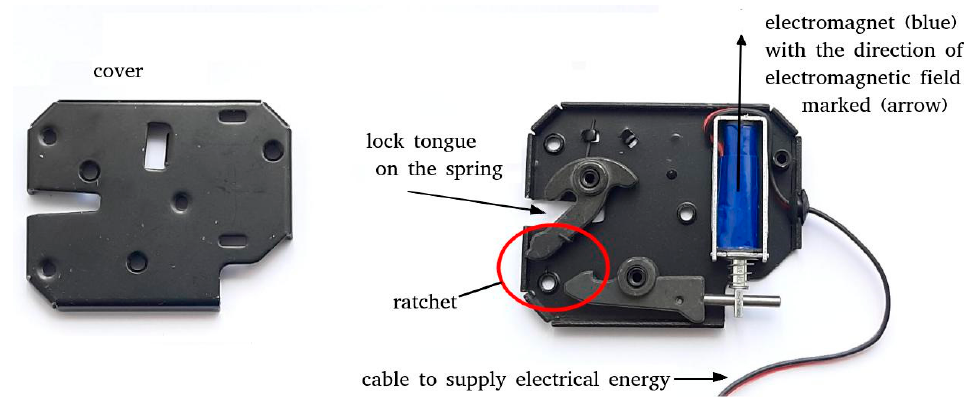
Figure 5. The internal structure of the electromagnetic lock with description.